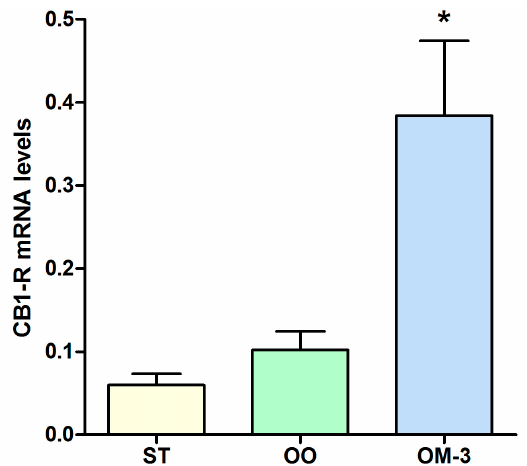
Figure 3. CB1 receptor gene expression levels (mean ± SE) in adipose tissue of 10 Apc Min/+ mice for each group. Data expressed as molecule numbers of CB1 receptor gene mRNA/molecule numbers of β -actin mRNA. * p < 0.05 (ANOVA and Dunnett’s multiple comparison test, each experimental group vs. the ST group).